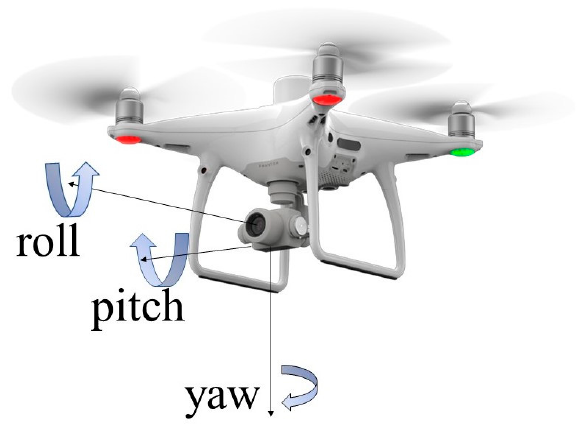
placed six GCPs on the beach. The white squares and the red circles are the feature points of the left and right videos, respectively.